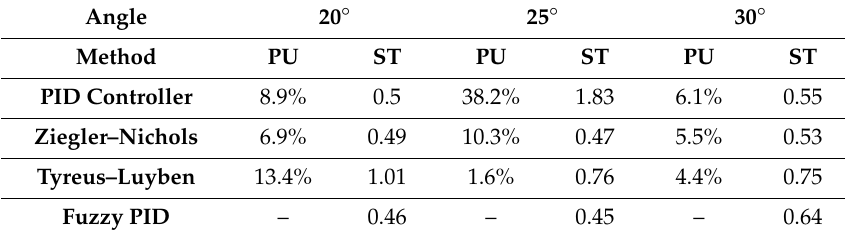
Figure 36. Tilt angle is approximately 30 degrees. Table 9. Comparison of Experiment II.